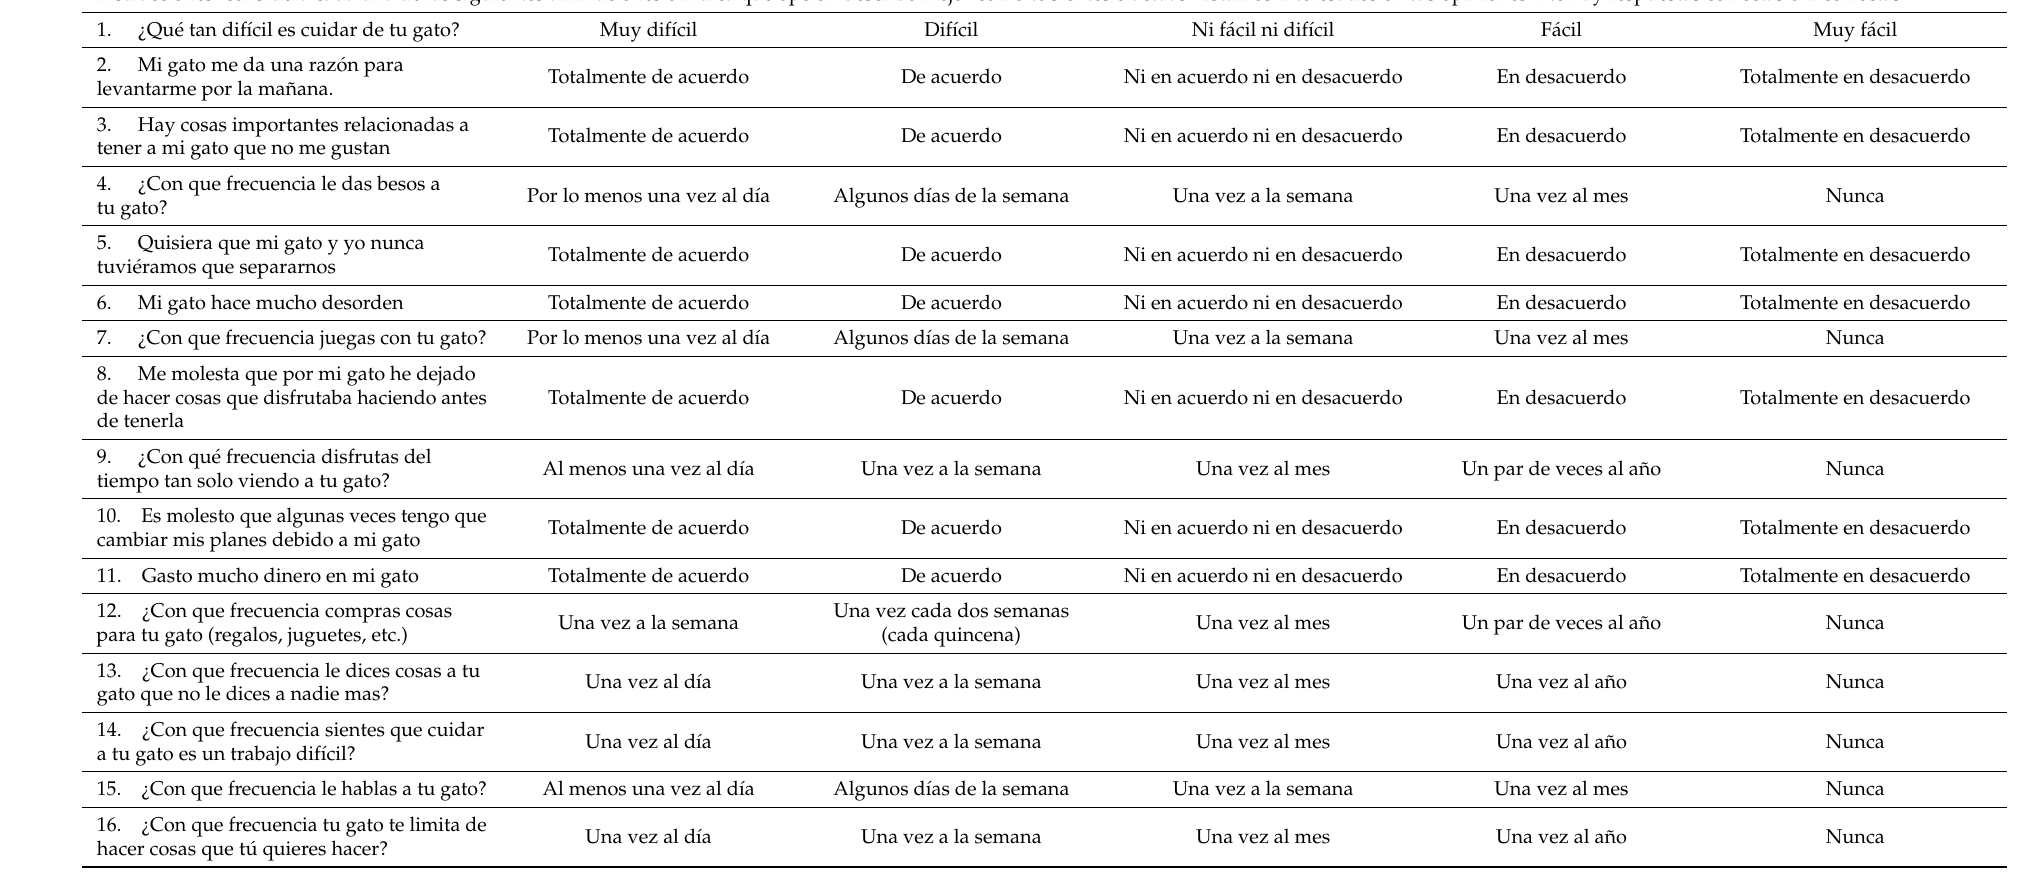
Table A1. Cat Owner Relationship Scale—Mexican Version